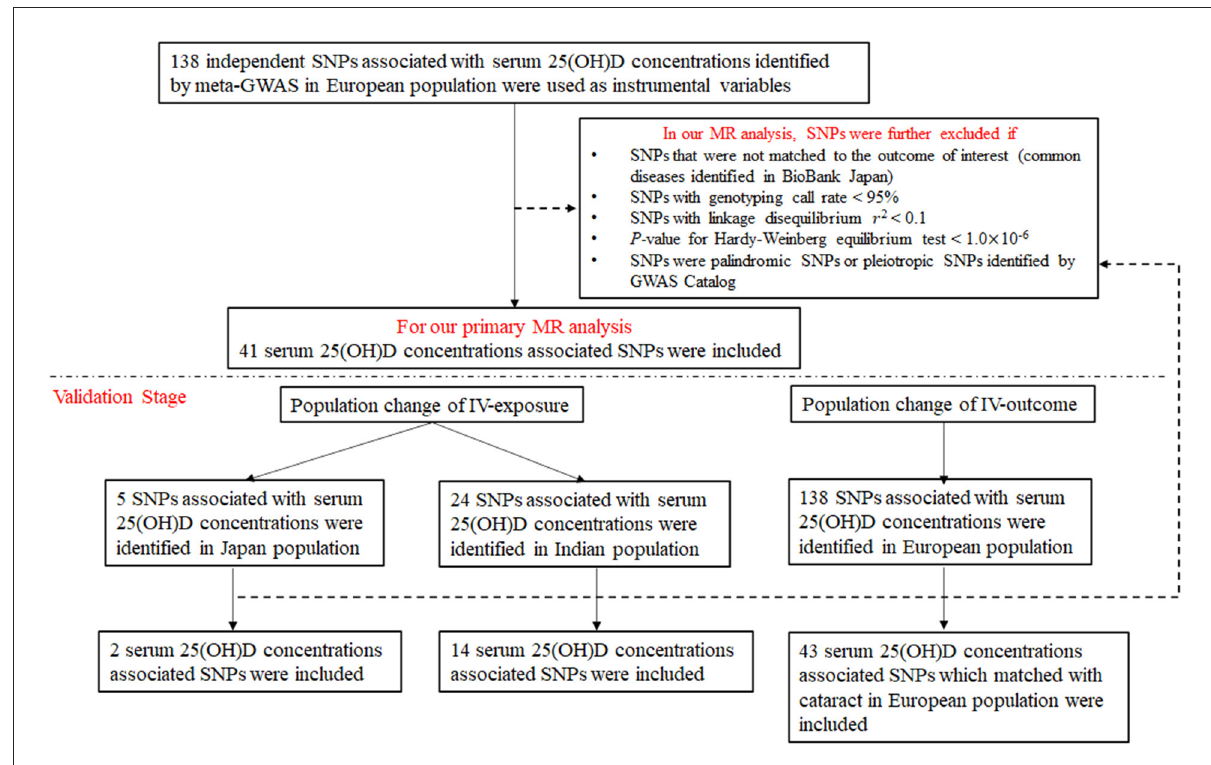
FIGURE1 Flowchart on the selection of instrumental